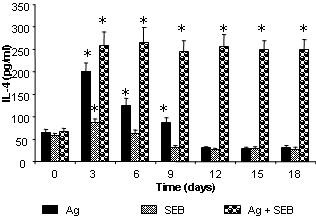
Separated PBMCs from patients with CRS-FA before FESS were cultured in the presence of specific antigens and SEB or antigen (or SEB) alone. Supernatants were sampled every three days and subjected to IL-4 analysis. Bars represent IL-4 levels in the supernatants (mean ± SD). *, p < 0.05, compared with IL-4 levels at day 0 within the same group.